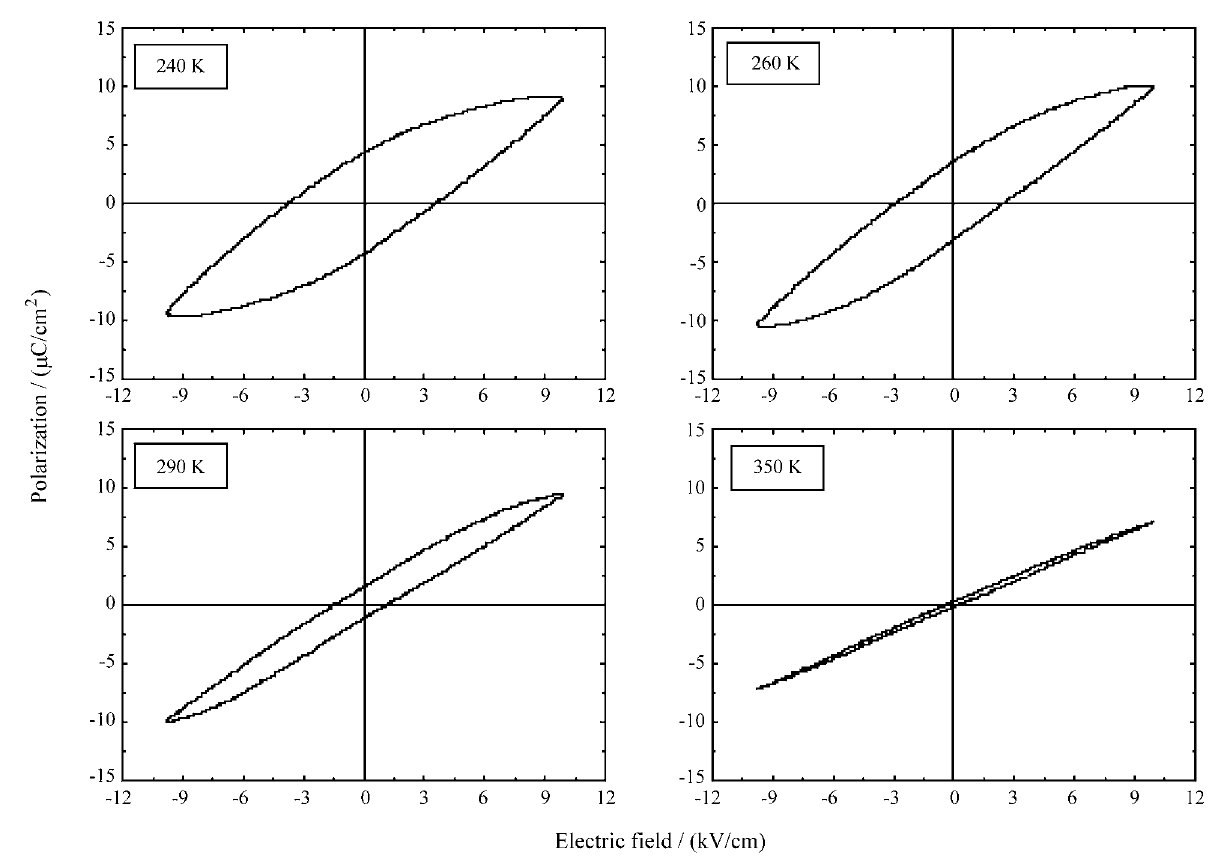
Figure 6. Temperature dependence of the hysteresis loops for the PLZT 10/65/35 ceramic.